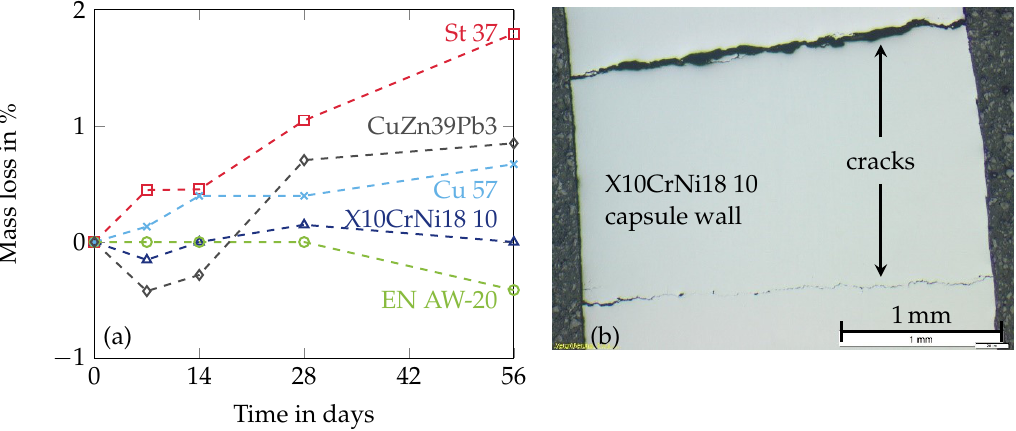
Figure 3. Results of the corrosion experiments with MCHH and various metals at a temperature of 122 ◦ C (a) and scanning electron microscope recording of a capsule made of stainless steel (b) [24]. Reproduced with permission from Brüggemann et al.